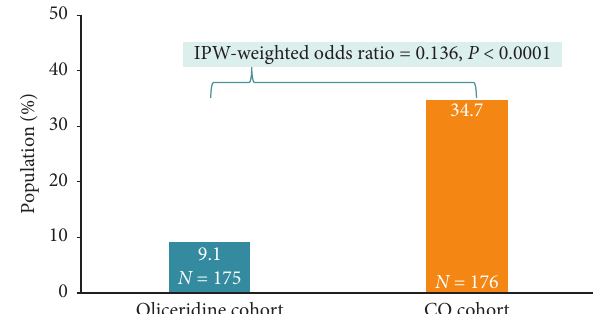
Figure 4: Incidence of opioid-induced respiratory depression in high-risk subgroup (secondary outcome). High-risk patients were defined as patients who were obese, or with a comorbid medical diagnosis of chronic obstructive pulmonary disease, renal im- pairment, or sleep apnea, or who were elderly (age ≥ 65 years at the time of treatment). Incidence of respiratory events was significantly lower in the oliceridine cohort in the high-risk